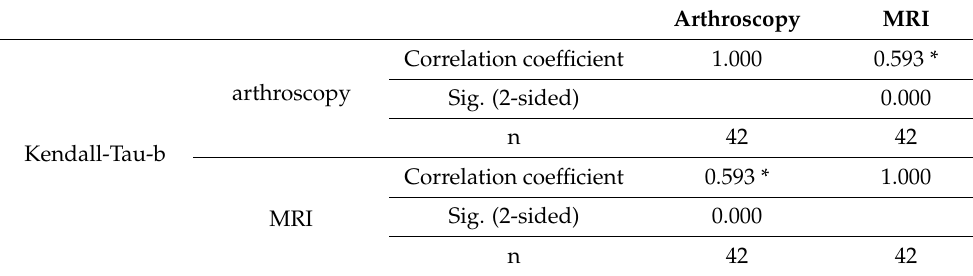
Table 3. Correlation between cartilage lesion stage in arthroscopy and CT. Arthroscopy CT Correlation coefficient 1.000 0.692 * arthroscopy Sig. (2-sided) 0.000 Kendall-Tau-b Correlation coefficient 0.692 CT